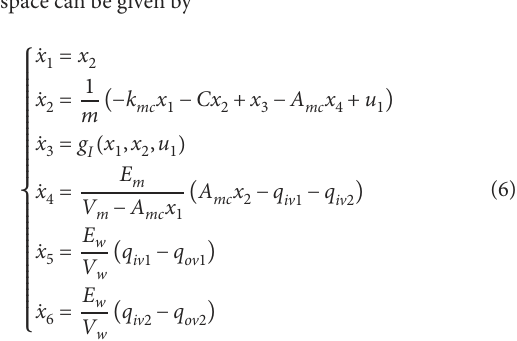
FIGURE 7 Polyhedral projection and convergence